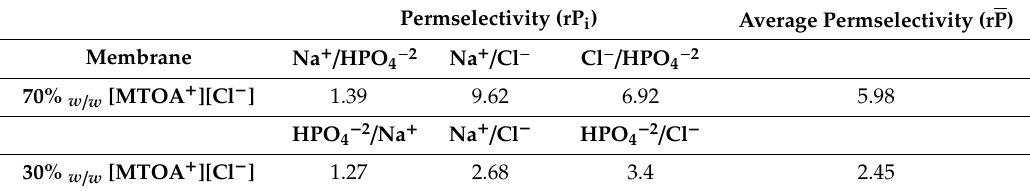
Table 3. Permselectivity values of the polymer inclusion membranes based on the liquid [MTOA + ][Cl − ] on the transport of CaCl 2 and Na 2 HPO 4